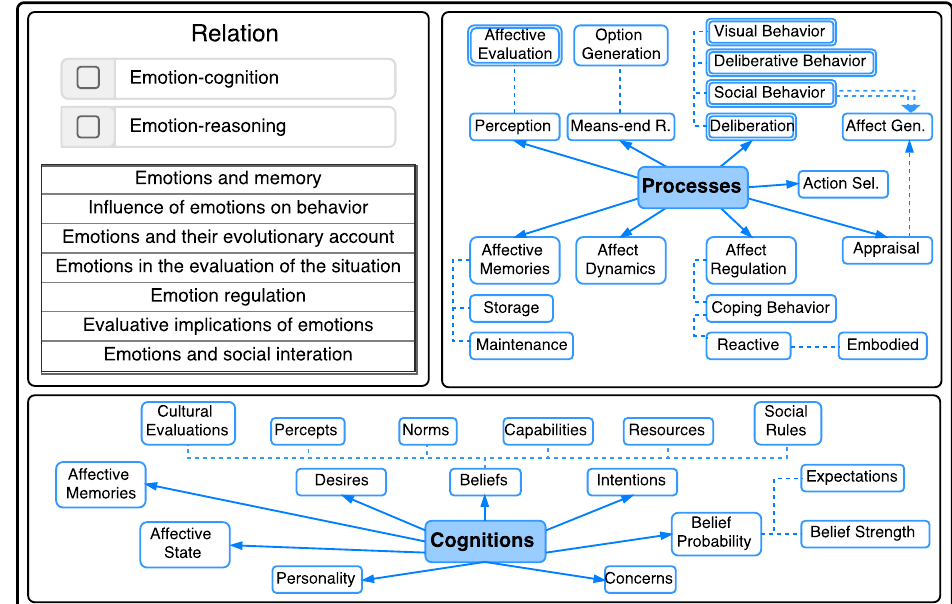
Figure 2. Framework proposed for the representation and analysis of the affect–cognition and affect– reasoning relations (left) and possible processes and cognitions (right) that can be addressed in a computational approach that models intelligent affective